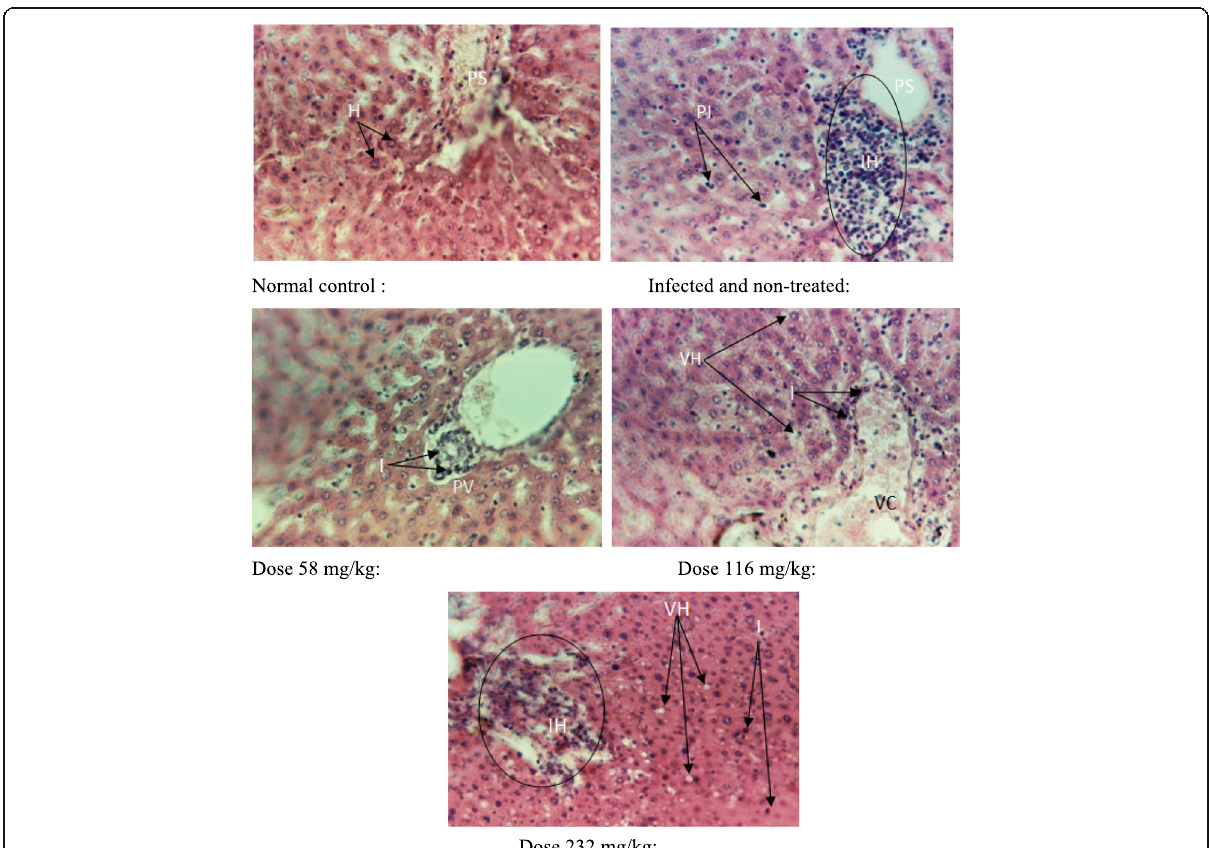
Fig. 4 Liver histopathological analysis. H: Hepatocytes, PI: Parenchyma inflammation, PS: Portal space, IH: Inflammation hall, I: Light inflammations, PV: Portal vein, VH: Vacuolization of hepatocytes, VC: Small vascular